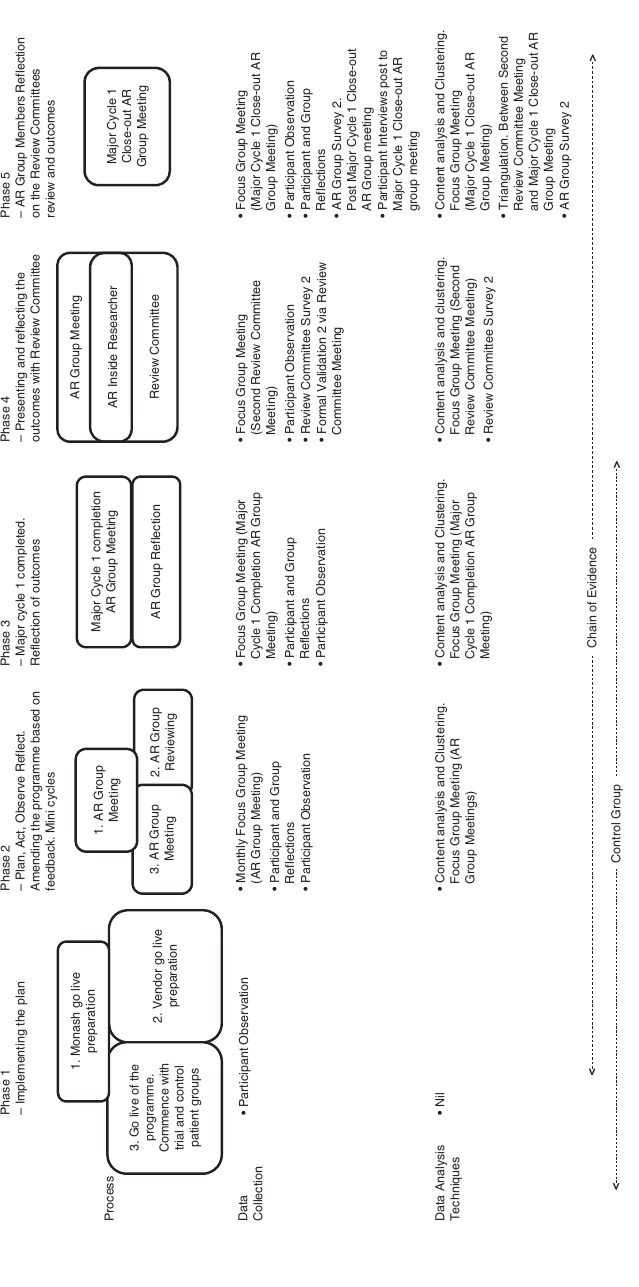
Figure 2. Major cycle 1: five months in